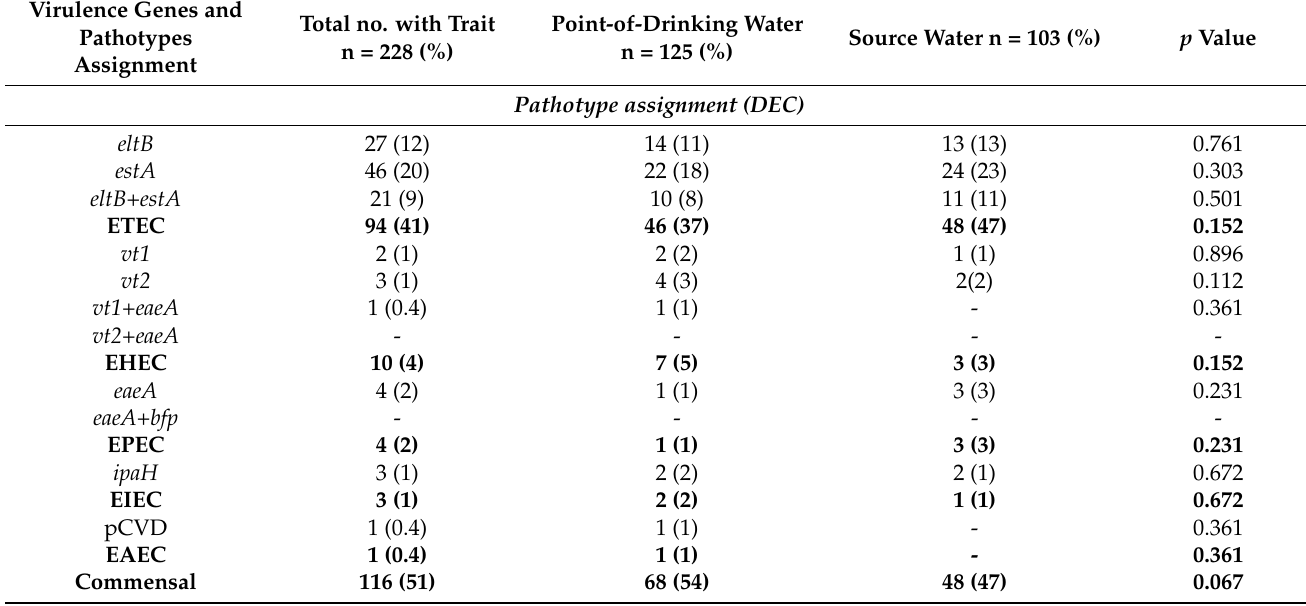
Table 2. Assignment of the pathotypes based on the virulence gene content and the distribution of other extended virulence genes. Pathotypes were assigned among 228 isolates of point-of-drinking and source water in Arichpur, Dhaka collected